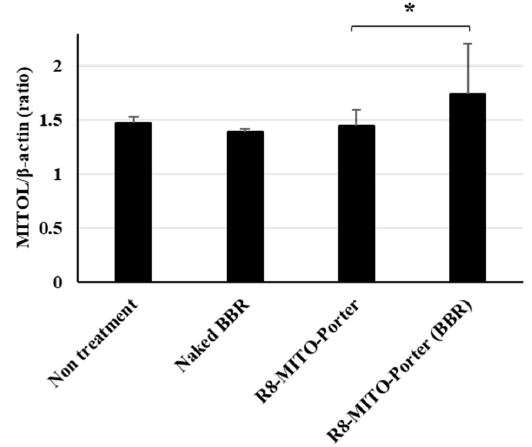
Figure 6. Evaluation of expression level of MITOL. Expression level of MITOL was evaluated using quantitative real-time PCR at 24 h after treatment with these samples. Fold change gene expression was determined using Ct values and normalized to β -action expression. Data are represented as the mean ± S.D. (n = 4). * p < 0.05, one-way ANOVA followed by Student–Newman–Keuls test.